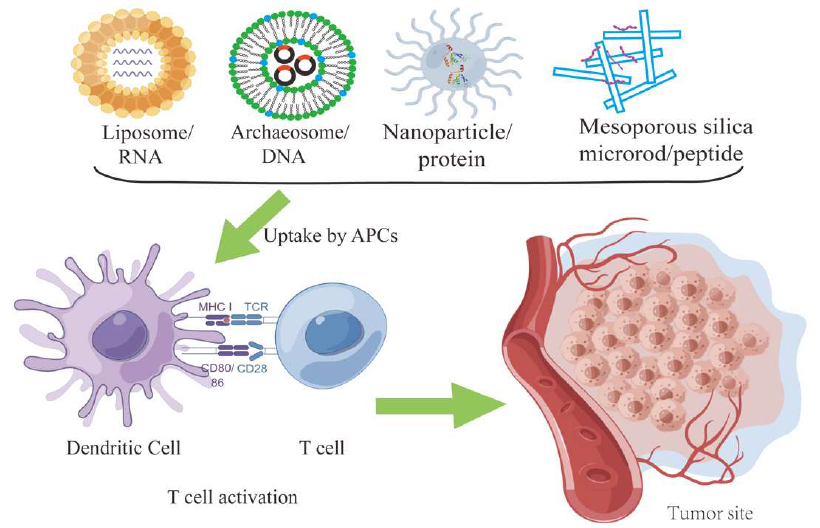
Figure 1. Various types of nano carriers have been constructed for the delivery of different cargos to antigen presenting cell to activate T cells. Several nano vaccines are shown here. The figure is drawn by